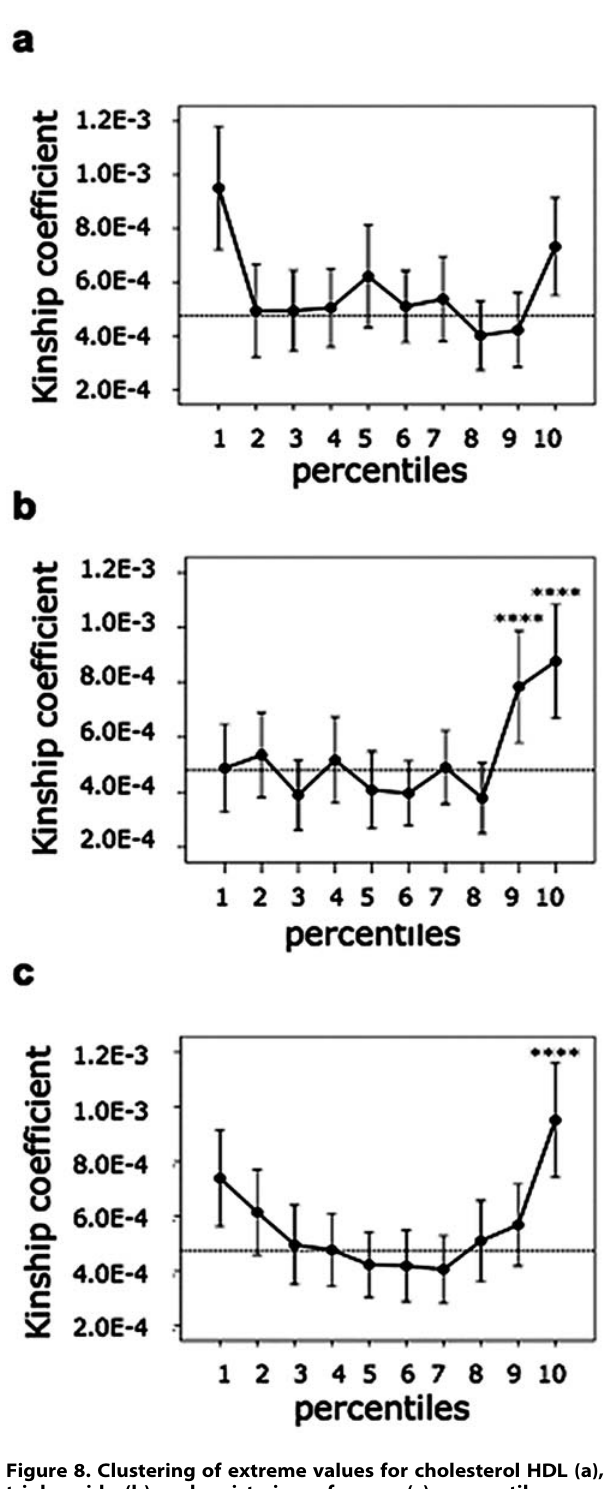
Figure 8. Clustering of extreme values for cholesterol HDL (a), triglyceride (b) and waist circumference (c): percentiles were constructed as described in the text, to account for the effect of sex and age. Kc was calculated within each percentile and the distribution was analyzed with ANOVA. Extreme percentiles were compared to the rest of the population and a p-value was calculated with the Mann-Whitney U Test: **** p-value , 0.0005.